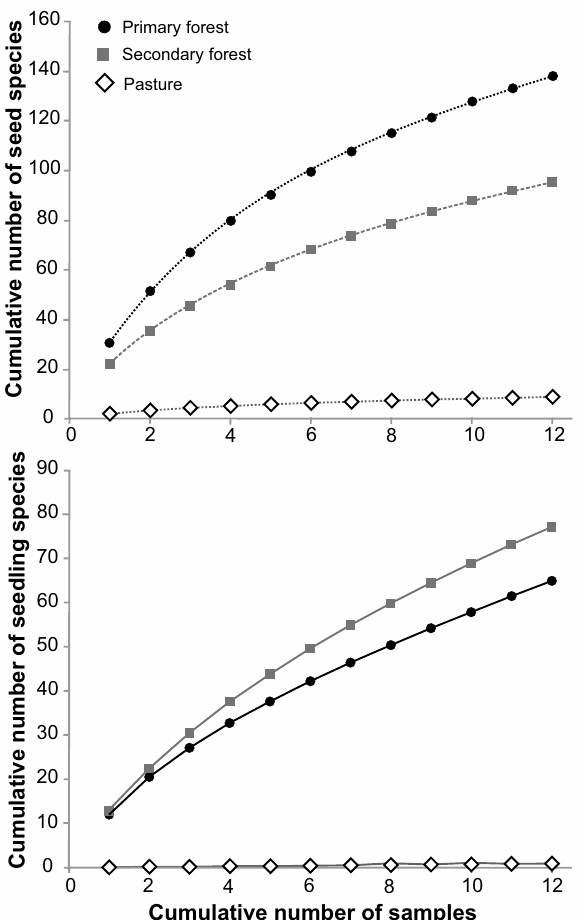
Figure A1. Species accumulation (Mao Tau) of seed and recruit samples over one year. Each sample is a species count in 1 m 2 seed trap (for seeds) and five adjacent 1 m 2 (for seedlings), with 12 samples of each per habitat per census. Black circles represent the primary forest (seed species at the top and seedling species at the bottom). For the purpose of metrics (Table A1), the sample area for pasture is increased as indicated in the methods section. Table A1. Dispersal and establishment limitation values for 33 tropical species in different habitats in Veracruz, Mexico. Calculations of limitation were obtained using the Muller Landau index and a density-weighted index.